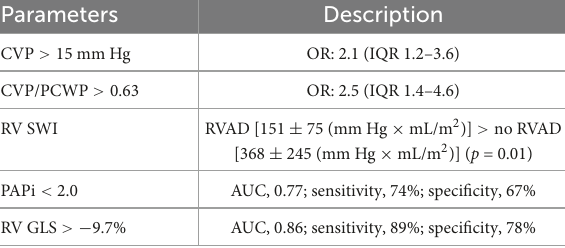
TABLE 1 Preoperative predictors for right ventricle failure following left ventricular assist device (LVAD) implantation. Parameters Description